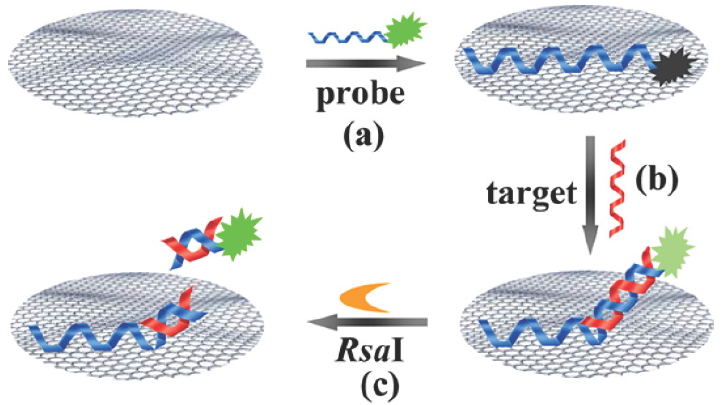
Figure 10. Illustration of miRNA assay based on coupling the fluorescence quenching of GO with site-specific cleavage of an endonuclease. The designed P1, which is labeled at its 5 ′ -terminus with a fluorophore, exhibits partial complementarity to the target (T1). The adsorption of P1 on the GO surface effectively quenches the fluorophore (step a). The hybridization of P1 with T1 leads to a non-GO absorbed duplex region and a single-stranded domain that is associated with the GO surface (step b). In the presence of the endonuclease, the 5 ′ -terminus of the duplex (containing the RsaI-recognized tetranucleotide sequence 5 ′ -GTAC-3 ′ ) is digested, resulting in the release of the fluorophore to the solution and recovery of the fluorescence signal (step c). The recovered fluorescence signal depends on the target concentration in solution. Reprinted with permission from [60]. Copyright 2013 American Chemical